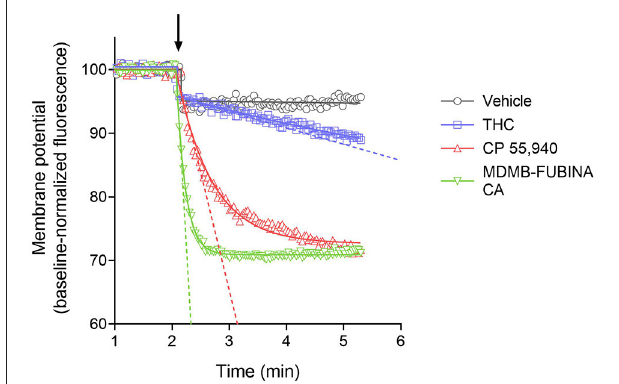
FIGURE 5 | Signaling kinetics of CB 1 receptor-mediated membrane potential reduction stimulated by CB 1 agonists. Membrane potential was measured using a fluorescent dye in AtT20 cells and data normalized to the baseline signal before application of agonist or vehicle (indicated by arrow). Data were analyzed by curve fitting to fall to steady-state equations as described in Materials and Methods. A maximally-stimulating concentration was used ( Table 2 ). THC produced a slow, small reduction of membrane potential, detectable beyond the small injection artifact reduction evident in the vehicle condition. The synthetic agonists CP 55,940 and MDMB-FUBINACA produced a more rapid and larger reduction (See the Supplementary Material File “CB 1 hyperpolarization time course fit results” for curve fit parameter results). The initial rate of signal generation by the agonist-occupied receptor (IR max ) was calculated from the curve fit parameters and this rate is indicated by the dashed line on the graph. Note the initial rate is much faster for CP 55,940 and MDMB-FUBINACA compared with THC. Data points are the mean of two technical replicates and data are from representative experiments.